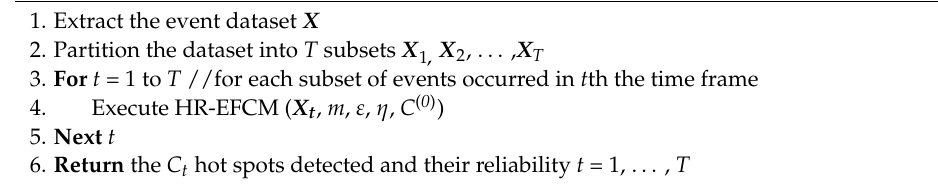
Algorithm 2 Spatiotemporal hot spots